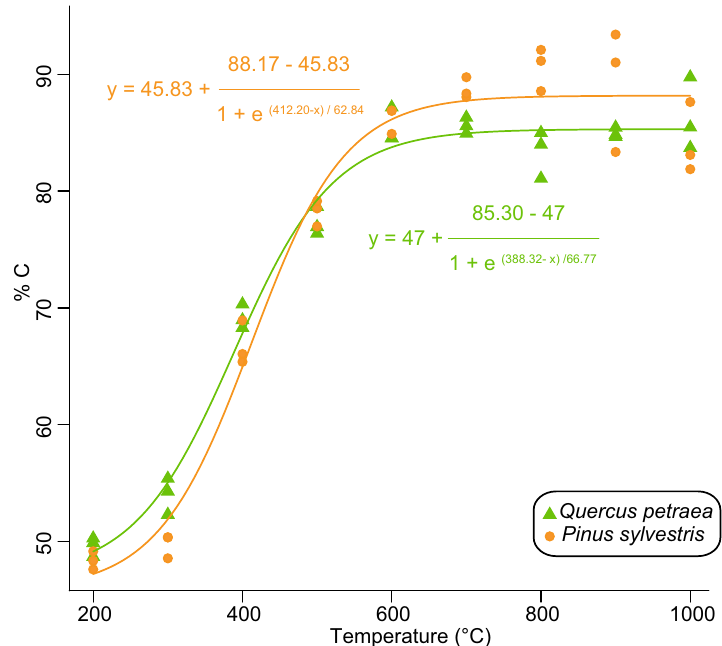
Figure 1. Relationships between carbonisation temperatures and %C in oak and pine charred